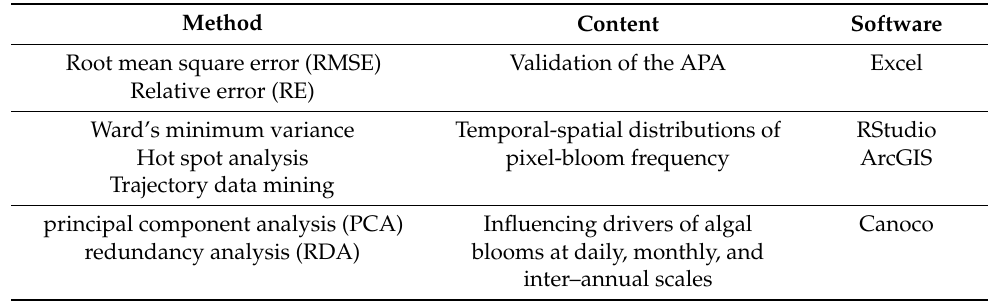
Table 2. Statistical methods for determining the spatial-temporal distribution and environmental drivers of the long-term sequence of algal blooms in Lake